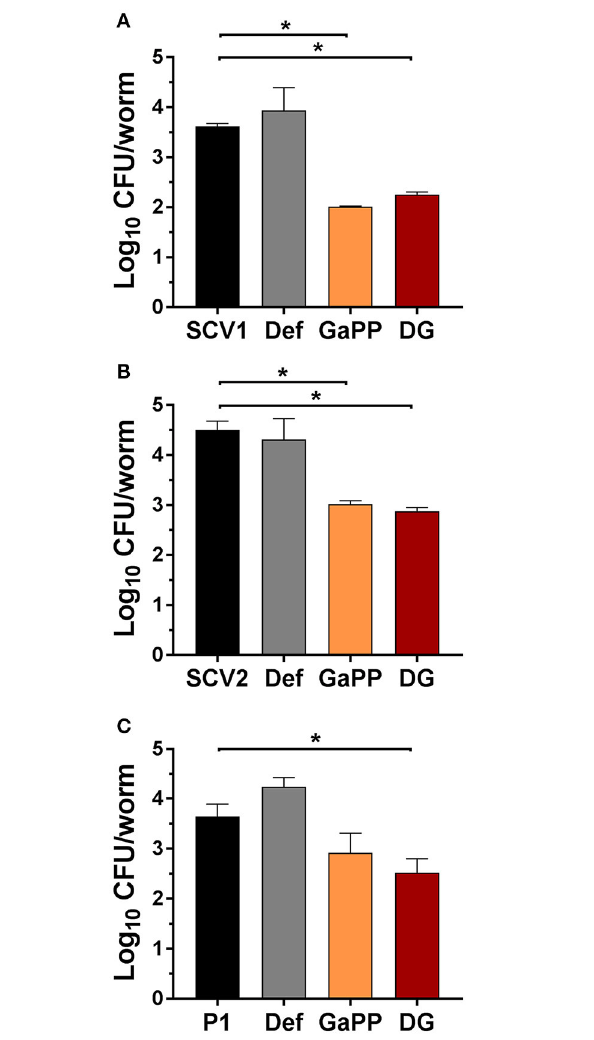
FIGURE 8 | Log 10 of CFU per C. elegans worm after 3 days infection (black bars) with small colony variant SCV1 (A) , SCV2 (B) or parent strain P1 (C) and treatment with drug loaded hydrogels- Def: deferiprone 20 mM (gray), GaPP, gallium-protoporphyrin 500 µ g/ml (orange) and DG, Def-GaPP500 (red). Data represent the mean ± SD of at least 6 biological replicates. * p <